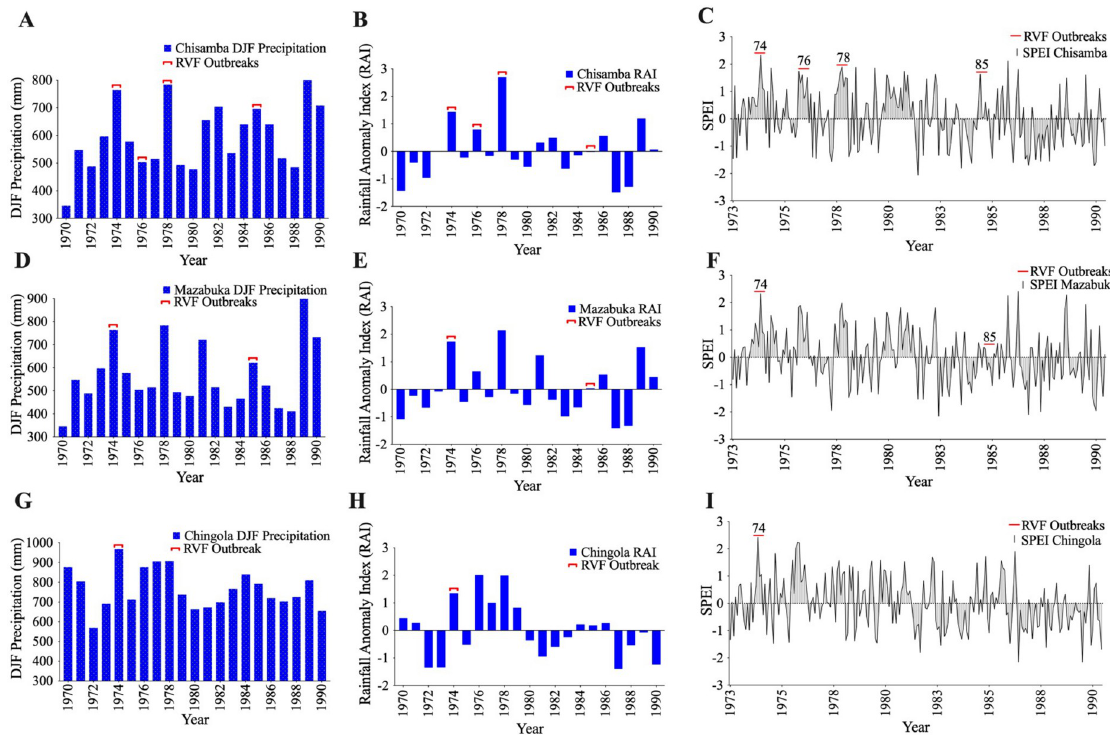
Fig 3. December-January-February (DJF) precipitation, rainfall anomaly index (RAI) and Standardized precipitation evapotranspiration index (SPEI) time-series analysis. (A,D,G) December-January-February precipitation during RVF outbreaks. (B,E,H) Rainfall anomaly Index indicating positive rainfall anomalies during RVF outbreaks. (C,F,I) Standardized precipitation evapotranspiration index (1973–1990) showing near normal, (-0.99–0.99), very wet (1.50–1.99) and extremely wet ( > 2.0) conditions during RVF outbreaks.